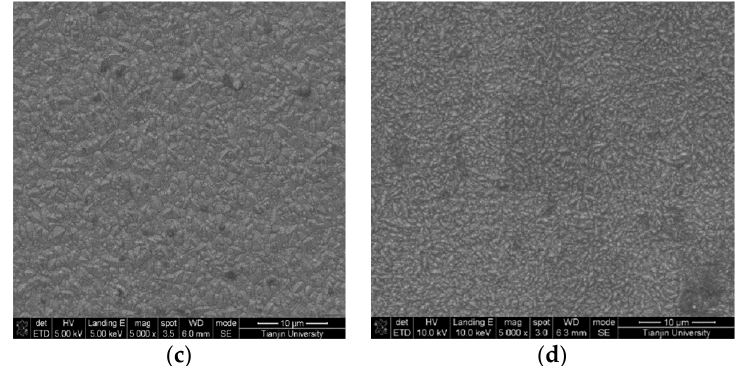
Figure 8. SEM images of the composite coating prepared at various current densities: ( a ) 2.0 A/dm 2 ; ( b ) 3.0 A/dm 2 ; ( c ) 4.0 A/dm 2 and ( d ) 5.0 A/dm 2 .